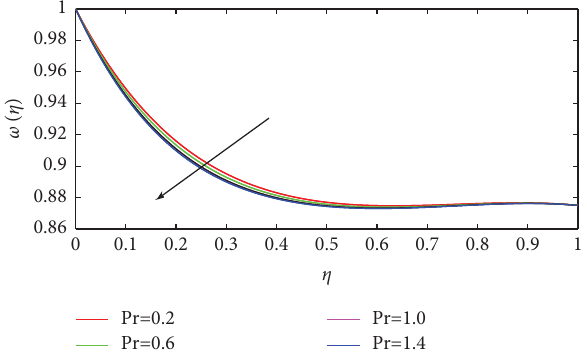
Figure 10: Temperature profles for the diferent values of Pr.